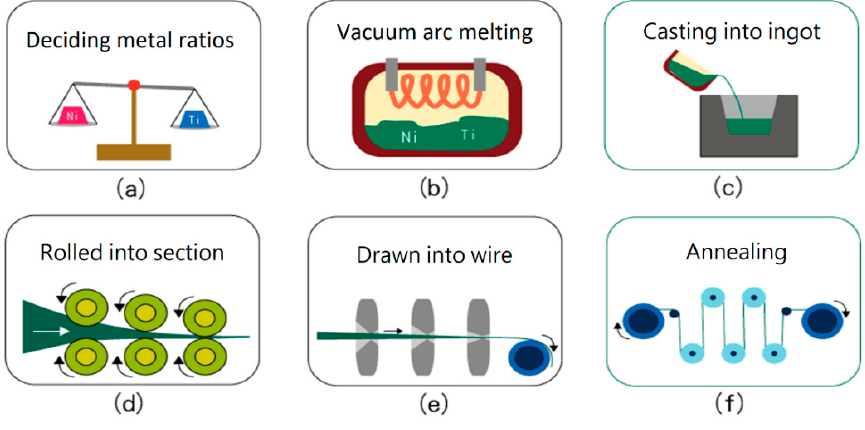
Figure 1. A simplified manufacturing process of the SMA.